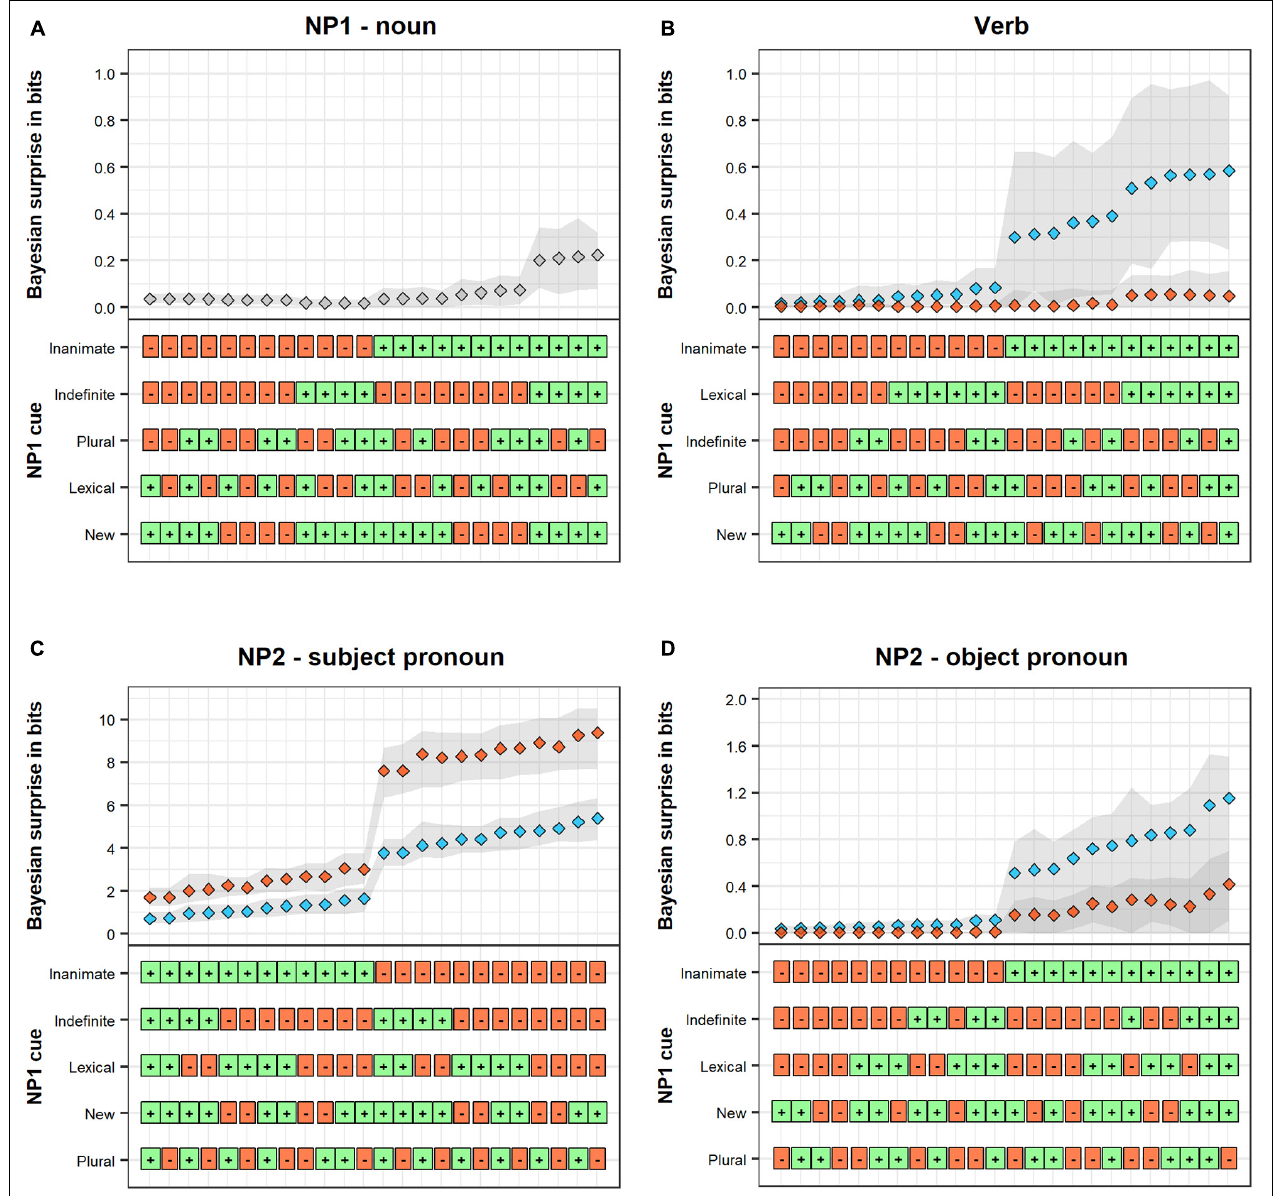
FIGURE 3 | Predicted Bayesian surprise of the NP1, verb, and NP2 constituents of a transitive sentence with a lexical NP1 and a 1st person pronoun NP2. Bayesian surprise is shown as a function of NP1 prominence cues (green square with plus indicates presence of feature) and verb semantics (red for volitional and blue for experience verbs). Panel A: Bayesian surprise on NP1 (verb semantic information not yet available). Panel B: Bayesian surprise on the verb. Panel C: Bayesian surprise for NP2 when NP2 is a case-marked object pronoun disambiguating toward SVO order. Panel D: Bayesian surprise for NP2 when NP2 is a case-marked subject pronoun disambiguating toward OVS order. Shaded areas illustrate 89% highest posterior density intervals (HPDIs) of predicted Bayesian surprise, calculated on the basis of the posterior predictions of the underlying GLMMs. Note that the range of the y-axis as well as the order of cues differ between plots. For each panel cues are ordered in decreasing importance from top to